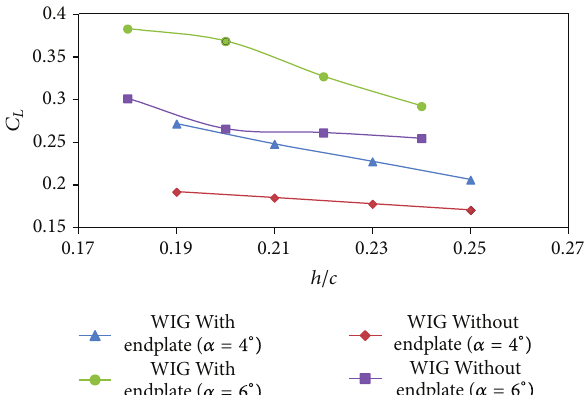
Figure 6: Lift coefficient ( 𝐶 𝐿 ) of WIG craft model with and without endplates versus ground clearance ( ℎ/𝑐 ) at different angles of attack.